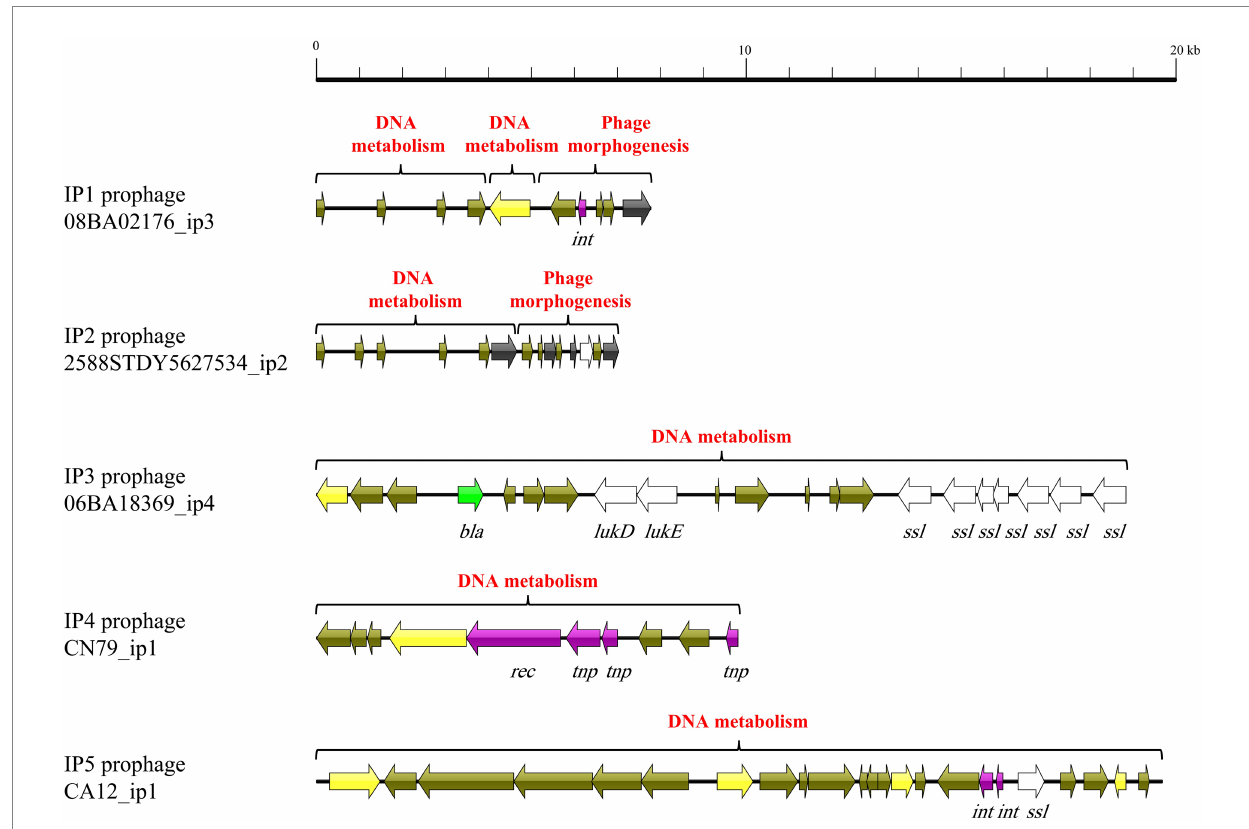
FIGURE 2 Mosaic structure of the main structure of incomplete prophages